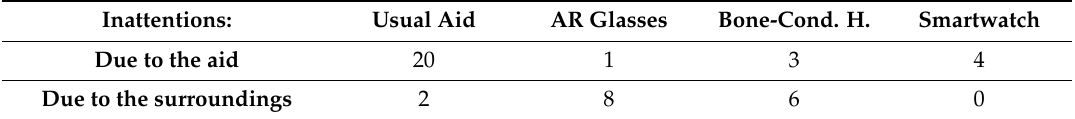
Table 3. Number of observed instances of inattention with the four navigation aids.